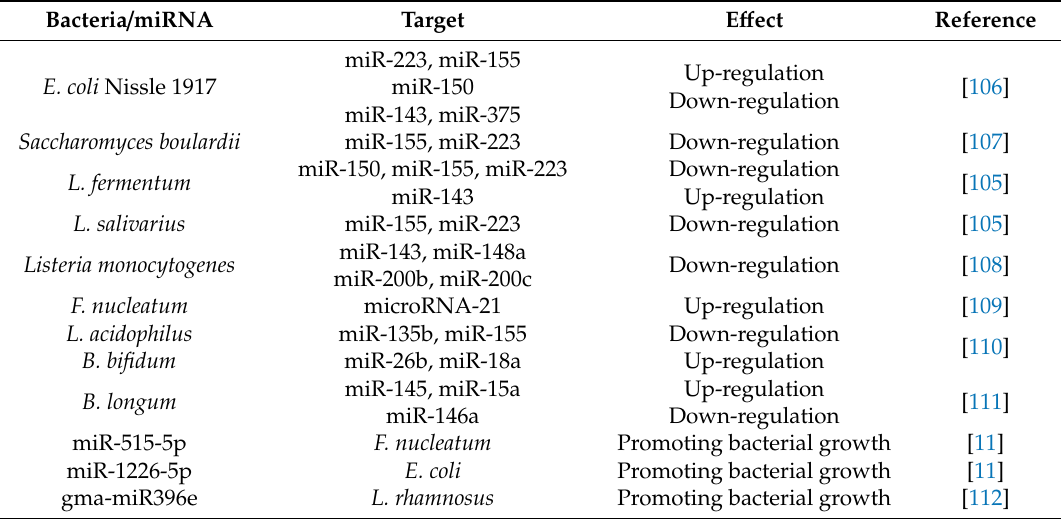
Table 2. MicroRNA-microbiota interaction in the host